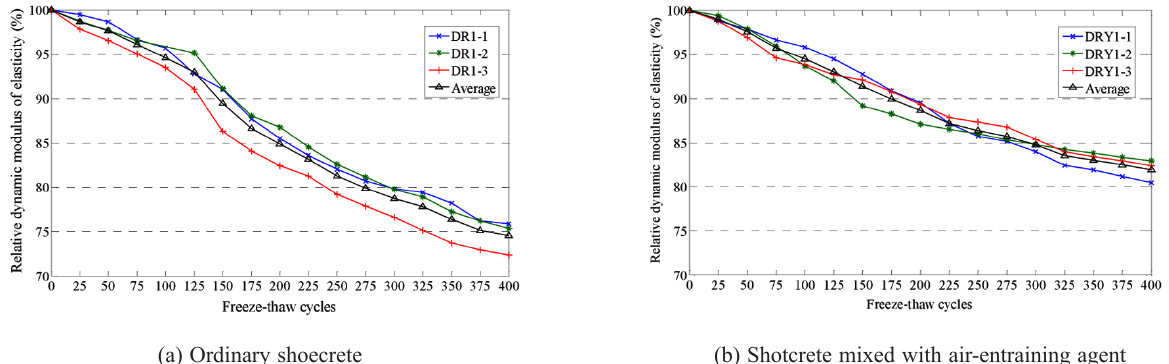
(a) Ordinary shoecrete (b) Shotcrete mixed with air-entraining Fig. 5. Change in relative dynamic modulus of elasticity of the shotcrete specimens during the freeze-thaw cycles